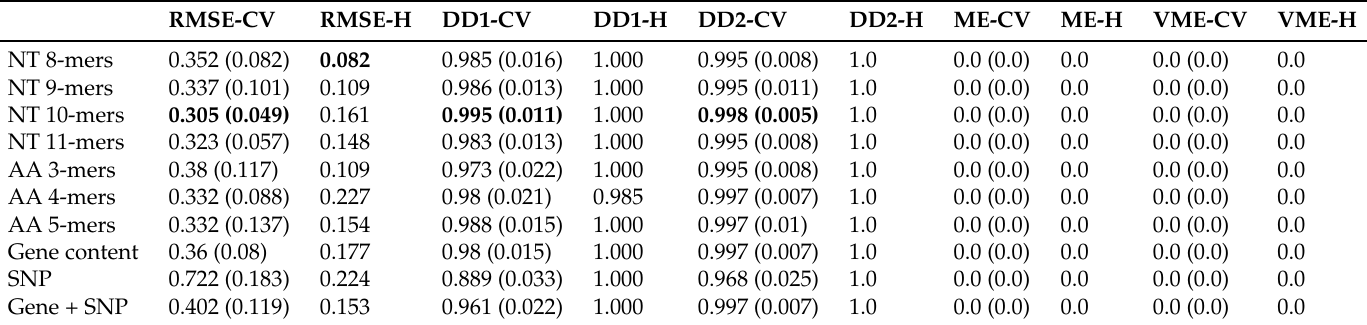
Table A25. N. gonorrhoeae –spectinomycin.